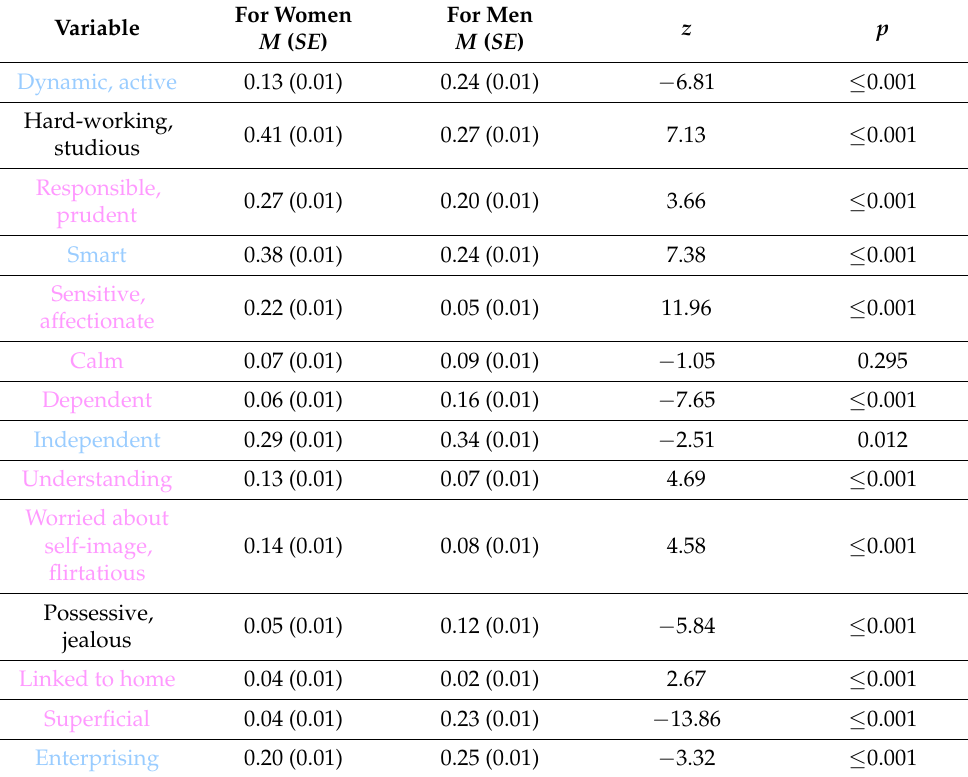
Table 3. Attributes selected to describe women and men: two-sample tests of proportions.